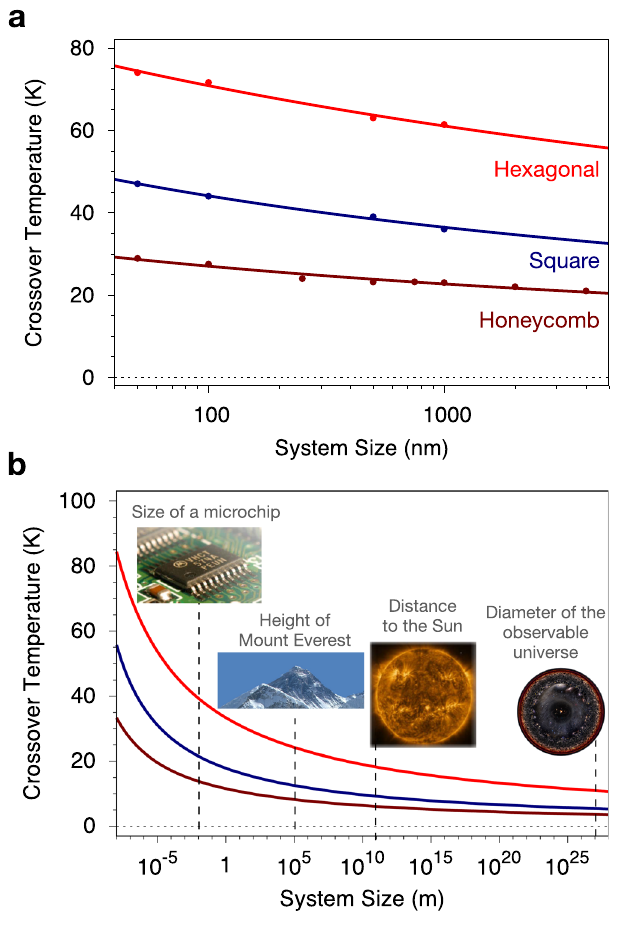
Fig.3|Sizescalingofthesimulatedcrossovertemperatureforthedifferent2D lattices. a Variation of the crossover temperature T x with system size for different symmetries (Hexagonal, Square, Honeycomb) on a log-scale. The curves are a fi t using T x = A = log ð L = B Þ ,where A and B are fi ttingconstantsand L isthesystemsize. A and B are 327.28 K and 0.000542nm, 484.96K and 0.00166nm and 1018.50K and 5.7×10 − 5 nm for honeycomb, square and hexagonal lattices,